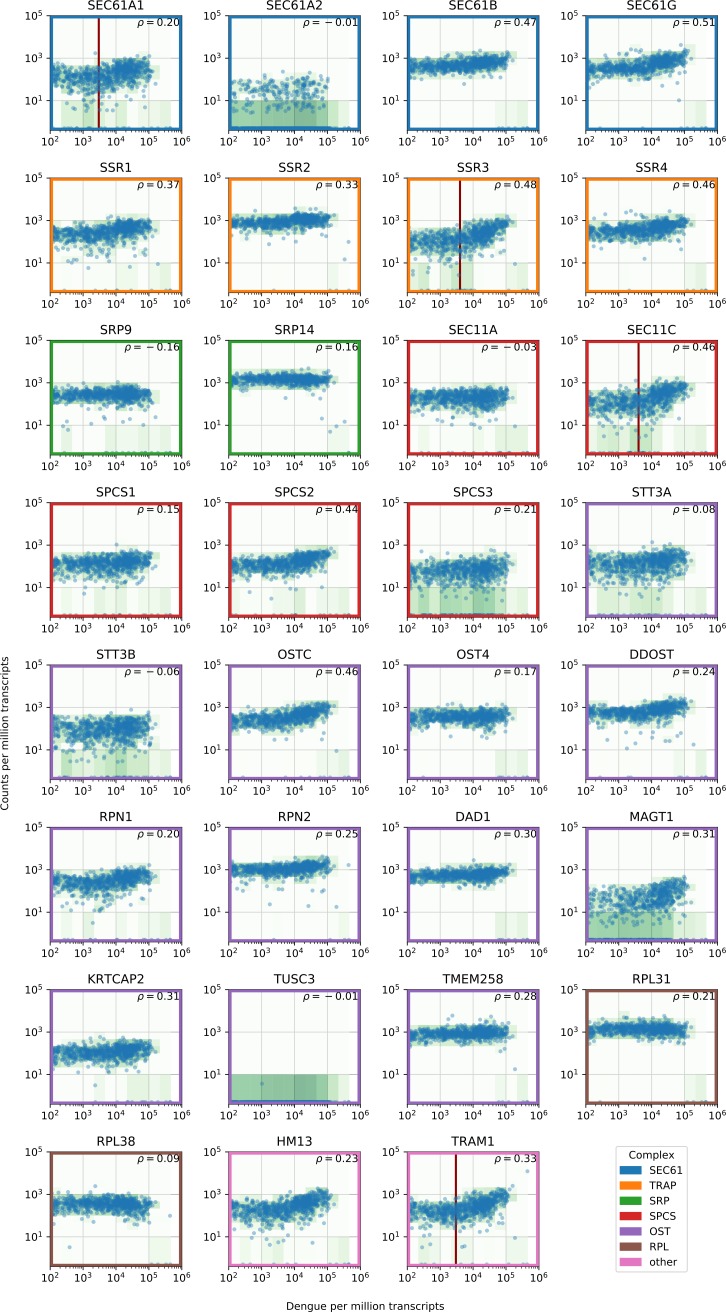
Gene expression versus vRNA level across all time points and MOIs during DENV infection for members of the translocon (SEC61), TRAP complex, signal recognition particle (SRP), signal peptidase complex (SPCS), oligosaccharide transfer complex (OST), plus two ribosomal proteins and two more proteins involved in ER translocation (HM13 and TRAM1).